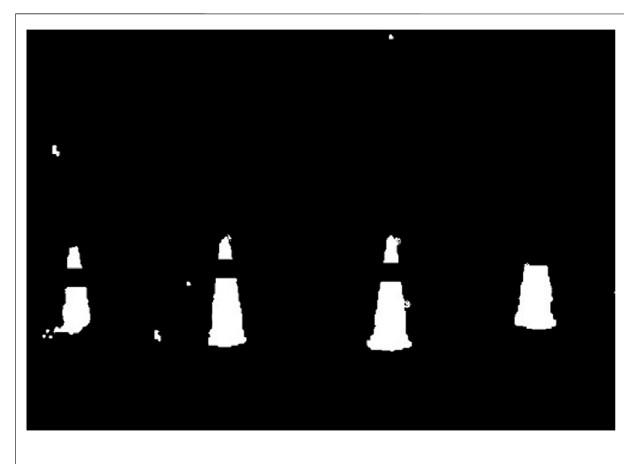
FIGURE 12 | Obstacle